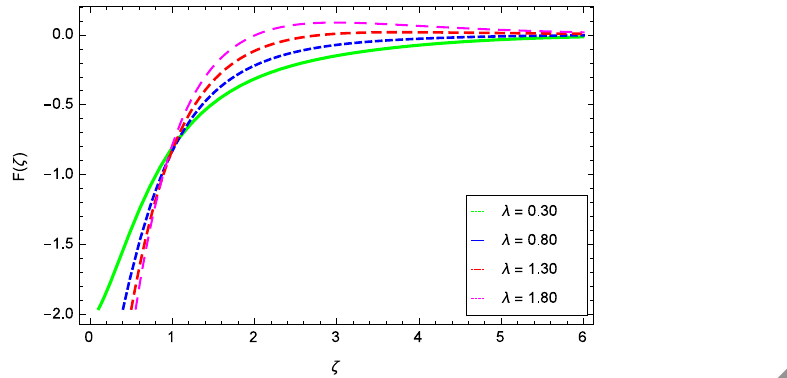
Figure 10. Effect of (cid:31) on radial velocity F (ζ) .